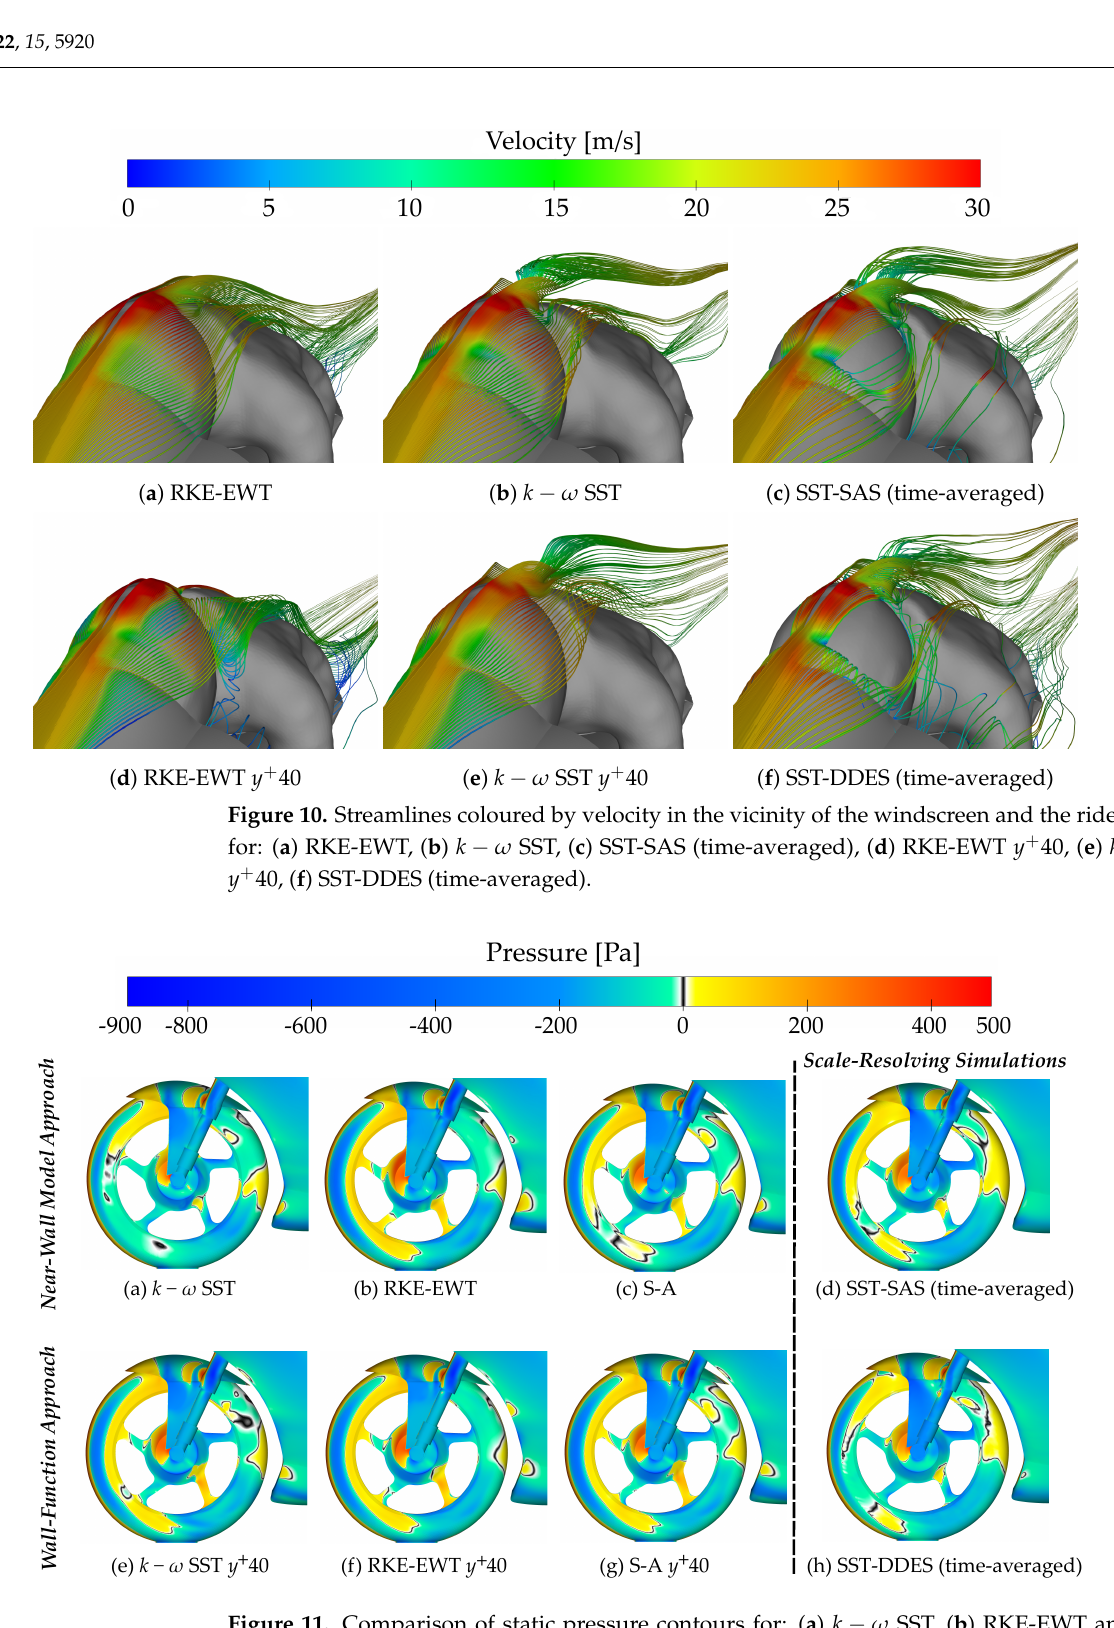
Figure 11. Comparison of static pressure contours for: ( a ) k − ω SST, ( b ) RKE-EWT and ( c ) S-A models using the near-wall model approach and the same models using the wall-function approach: ( e – g ) together with SRS models (time-averaged): ( d , h ) for motorcycle front wheel. Analysis of the area of higher pressure on the tyre indicates noticeable differences in the pressure distribution between the simulations with the near-wall model approach and those with the wall-function modelling. This is in line with our expectations as models with a wall-function are unable to correctly predict separation points in the areas with